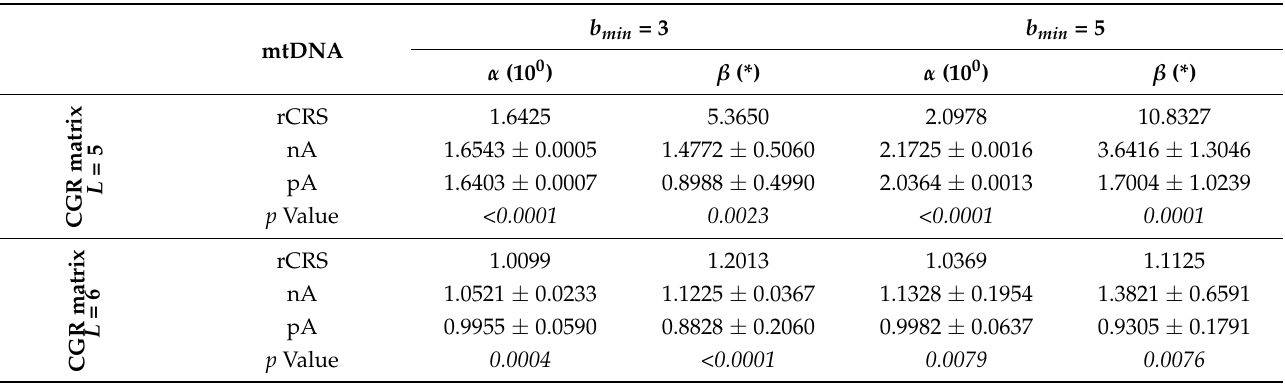
Table 3. Fractal parameters of mtDNA CGR matrices from hyperbola model function-based lacunarity method.